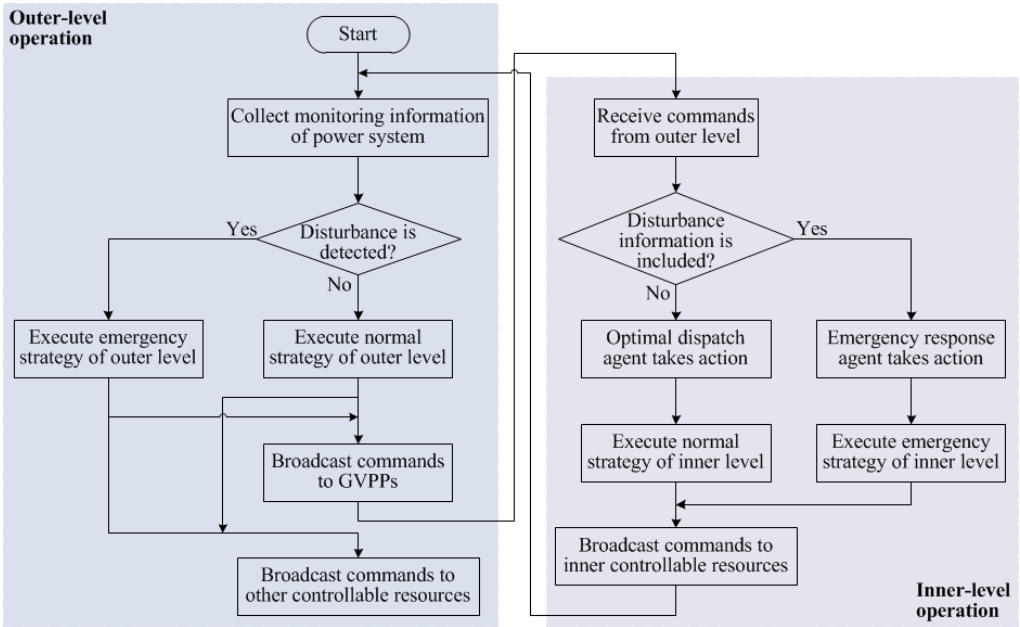
Figure 10. Flowchart of the operation of the bi-level dispatch and control architecture.